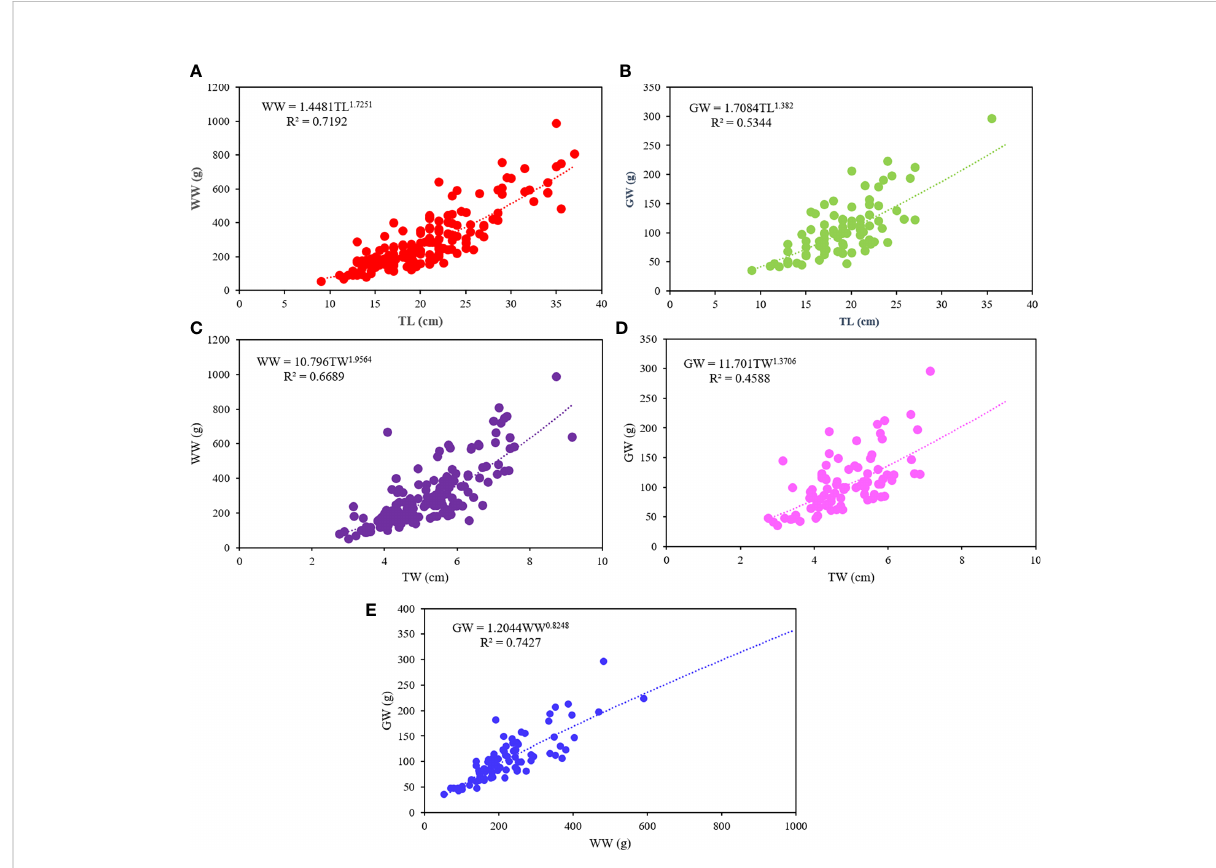
FIGURE 3 Allometric relationships for Holothuria tubulosa . (A) WW-TL relationship; (B) GW-TL relationship; (C) WW-TW relationship; (D) GW-TW relationship; (E) GW-WW relationship. TL, total length; WW, wet weight; GW, gutted weight; TW, total